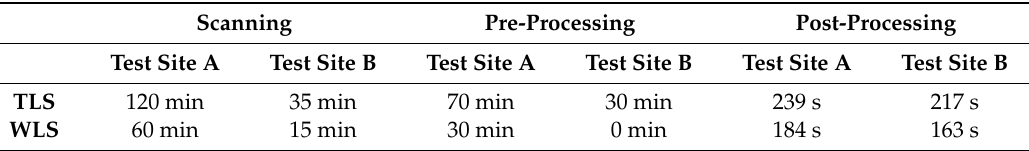
Table 4. Times required for the different operations to detect trees from point clouds and to estimate DBH and TH. Both measurement systems (TLS and WLS) and test sites are